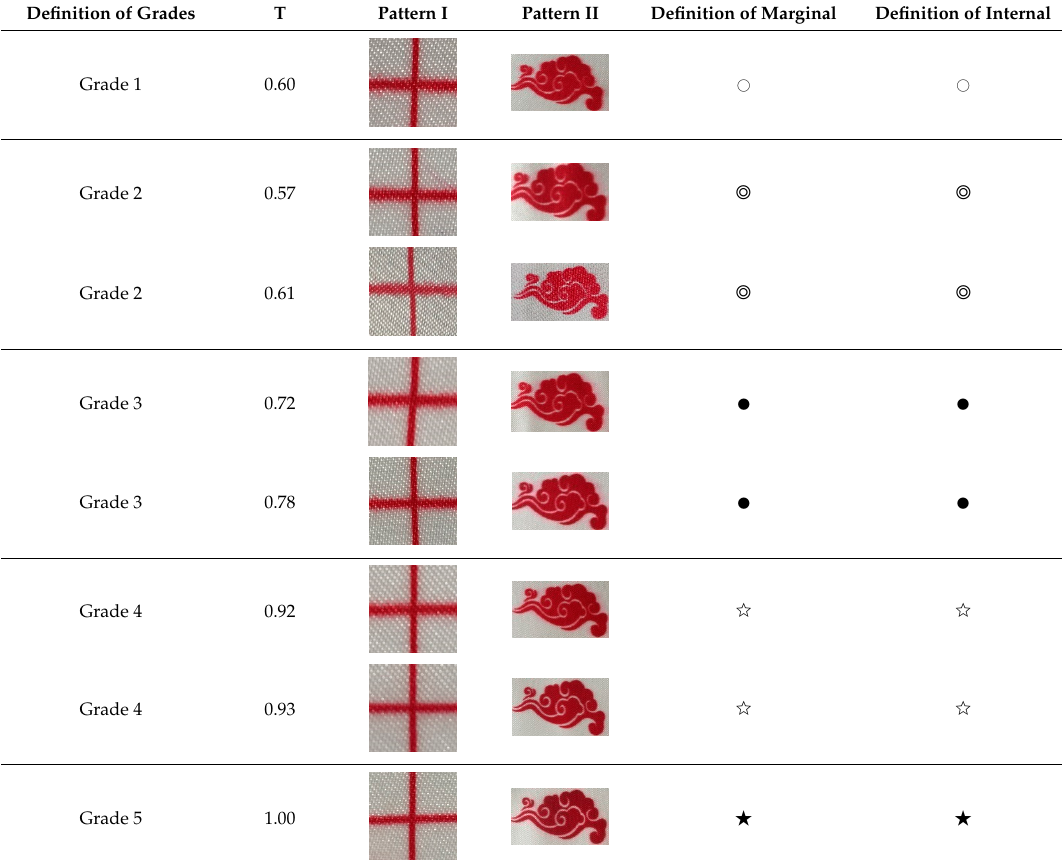
Table 2. Relation of ink drop experiment and line width of actual printing.